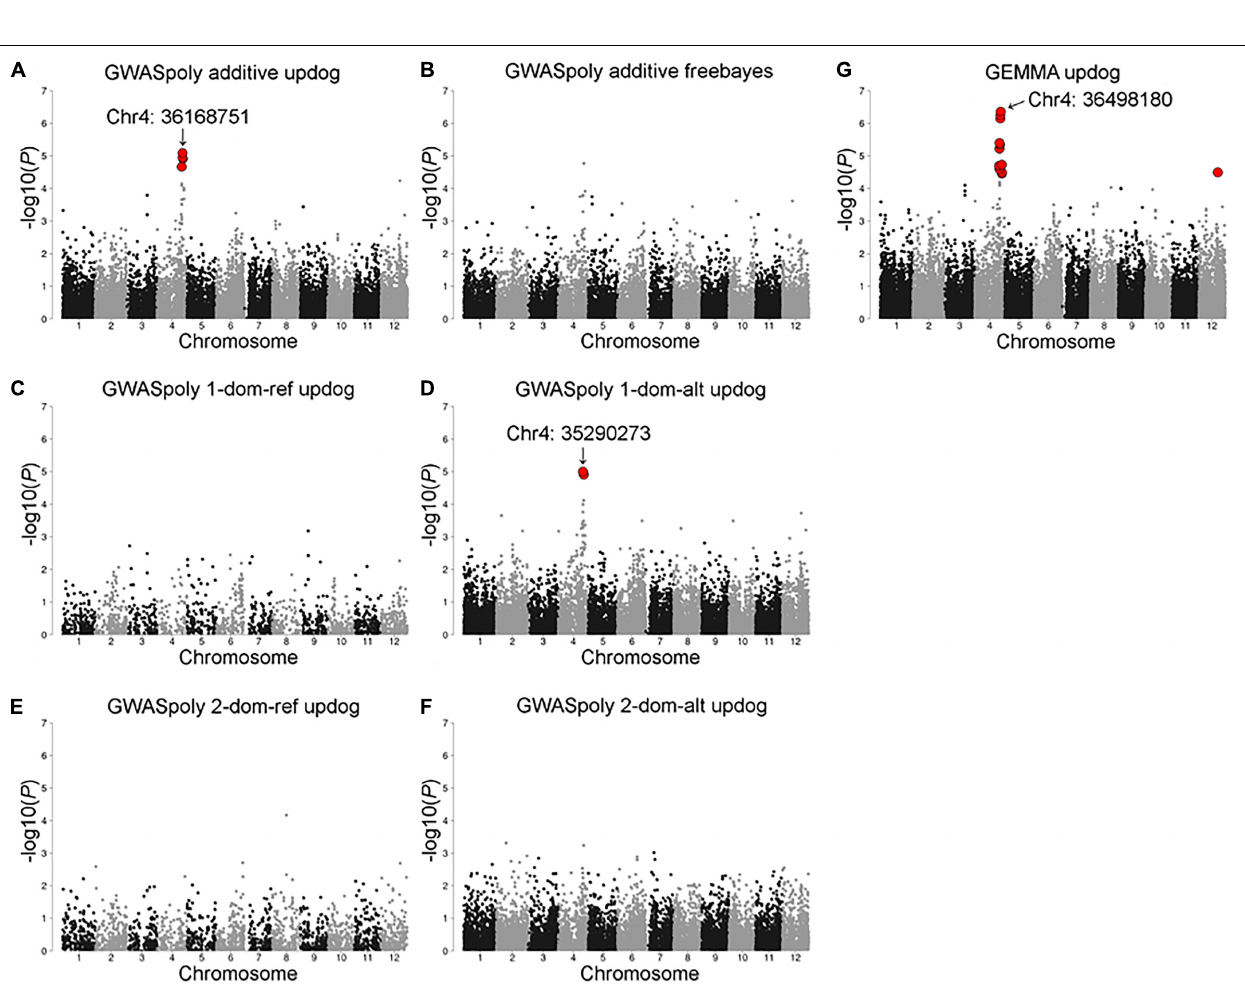
FIGURE 4 | Model selection for the CR in the 2018–2019 season. Genome-wide association study result by (A) GWASpoly additive model with single nucleotide polymorphism (SNP) discrete genotype call, (B) GWASpoly additive model with haplotype-based genotype call, (C) GWASpoly reference simplex dominant model,